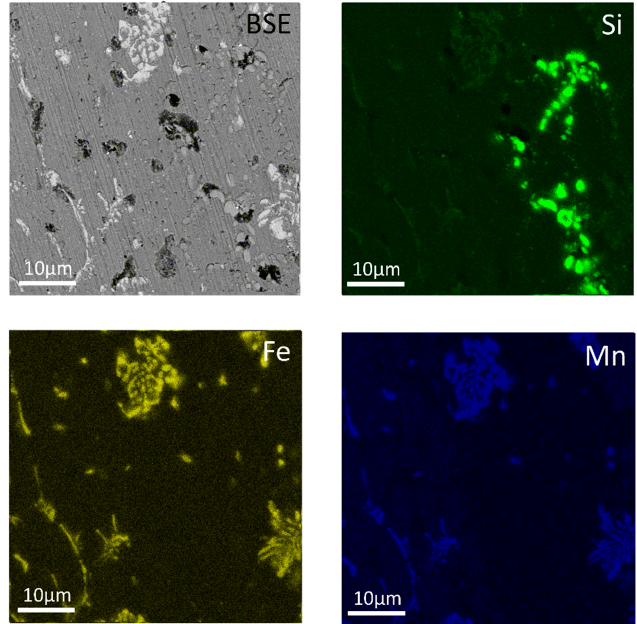
Figure 2. Microstructure of the TRC specimen after annealing at 450 °C for 8 h. Original and newly formed voids appear as darker areas in the BSE image.